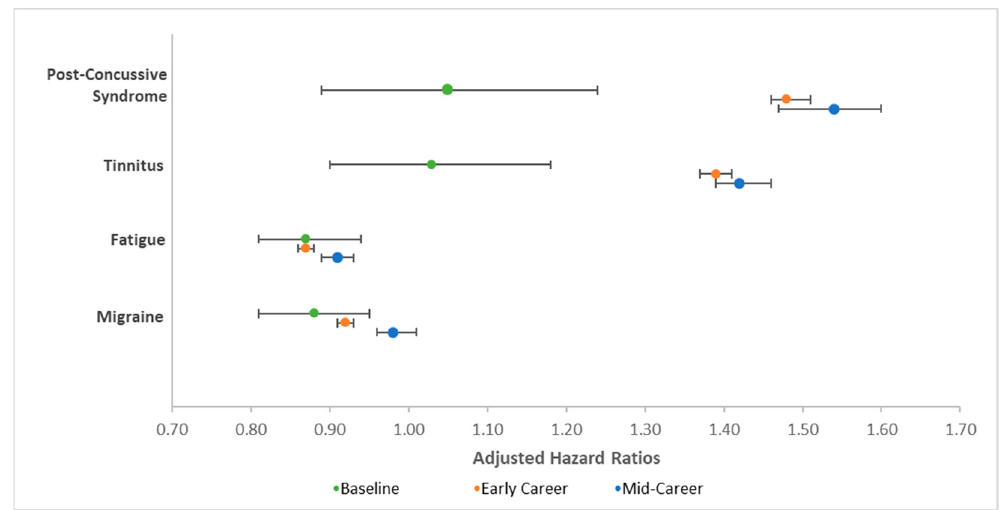
Figure 5. Graph of adjusted hazard ratios depicting decomposition of significant interaction between occupational risk of low-level blast (LLB) and time in risk for conditions hypothesized to be related to LLB. Adjusted hazard ratios represent the odds of being diagnosed with the conditions denoted as a function of occupational risk of LLB. Error bars represent 95% confidence intervals.